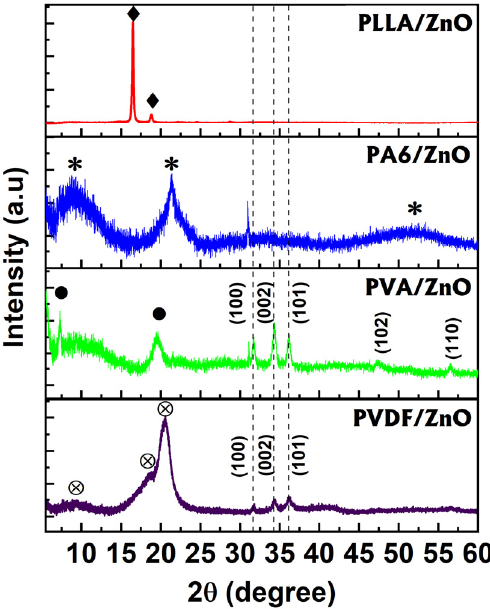
Figure 3. XRD patterns of the PVDF / ZnO, PVA / ZnO, PA6 / ZnO, and PLLA / ZnO nanofibers (symbols: black rhomb—PLLA, stars—PA6, black circles—PVA and crossed circles—PVDF; dot lines—ZnO).